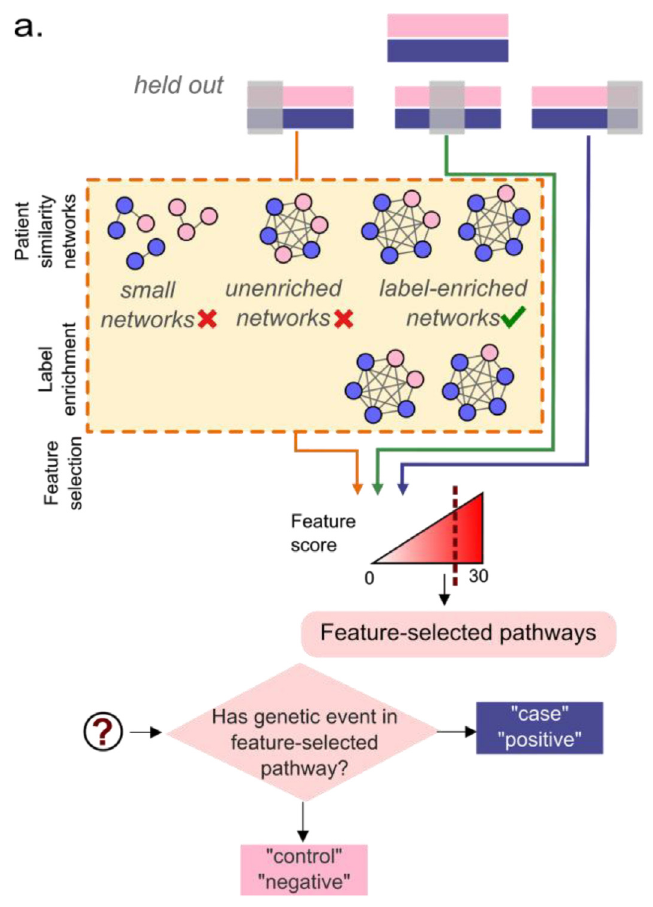
Figure 9. Predictor design for binary classification of case/control diagnosis in netDx, starting from rare CNVs. CNVs are grouped into pathway-level features and patient similarity is binary; i.e. two patients have similarity of one if they share CNVs in genes from the same pathway. Feature selection is iteratively performed on independent thirds of the sample set. This design uses an additional label enrichment step that precedes feature selection. Label enrichment filters out networks with insufficient bias towards case-case edges, using a label-based permutation approach. Networks with significant label enrichment are used in feature selection. Scores from all three feature- selection splits are added to get a final score for each feature, with a maximum attainable score of 30. Test patients are classified as cases if they carry a CNV in a pathway that passes feature